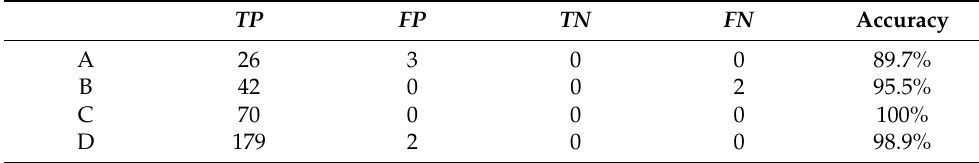
Table 8. Semi-supervised learning results.